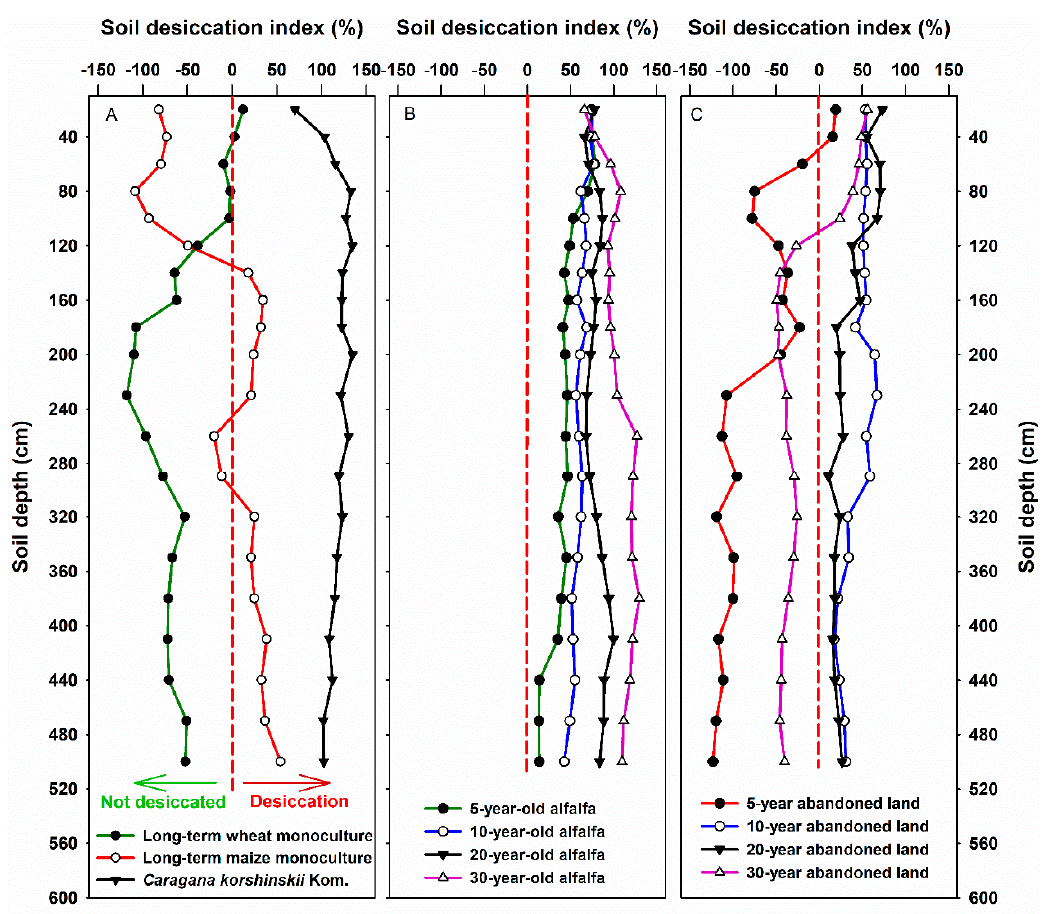
− 500 cm soil profiles under long-term